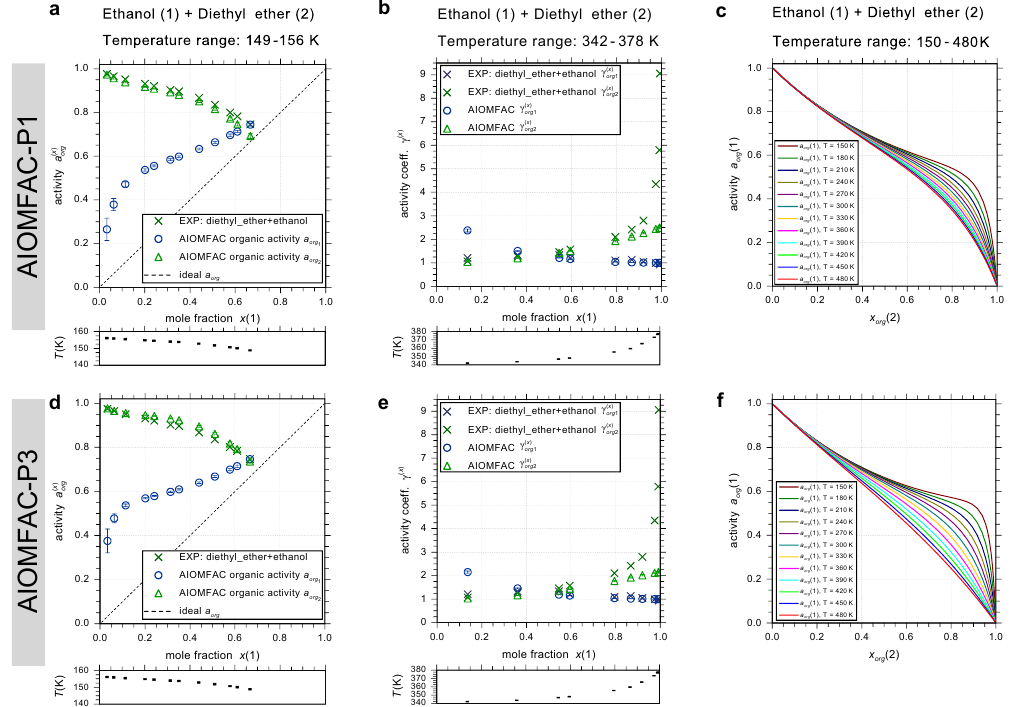
Figure 10. SLE and VLE measurements for ethanol (1) + diethyl ether (2) solutions and corresponding calculations of AIOMFAC-P1 (a–c) or AIOMFAC-P3 (d–f) . Panels (c, f) show the temperature dependence of the ethanol activity, as predicted by AIOMFAC-P1 and AIOMFAC-P3 for the temperature range 150–480K. (a, d) Experimental SLE data (crosses) compared with model predictions (triangles) for the activity of diethyl ether in the very low temperature range 149 to 156K. The dashed line is the ideal solution curve for component 1. Panels (b, e) show the model predictions of the activity coefficients compared to VLE data covering temperatures significantly higher than room temperature. The temperatures of the individual data points are given in the boxes below the main panels. The error bars represent the model sensitivity to a composition variation by x tol = 0 . 01. Experimental data: Lalande (1934) and Moeller et al.